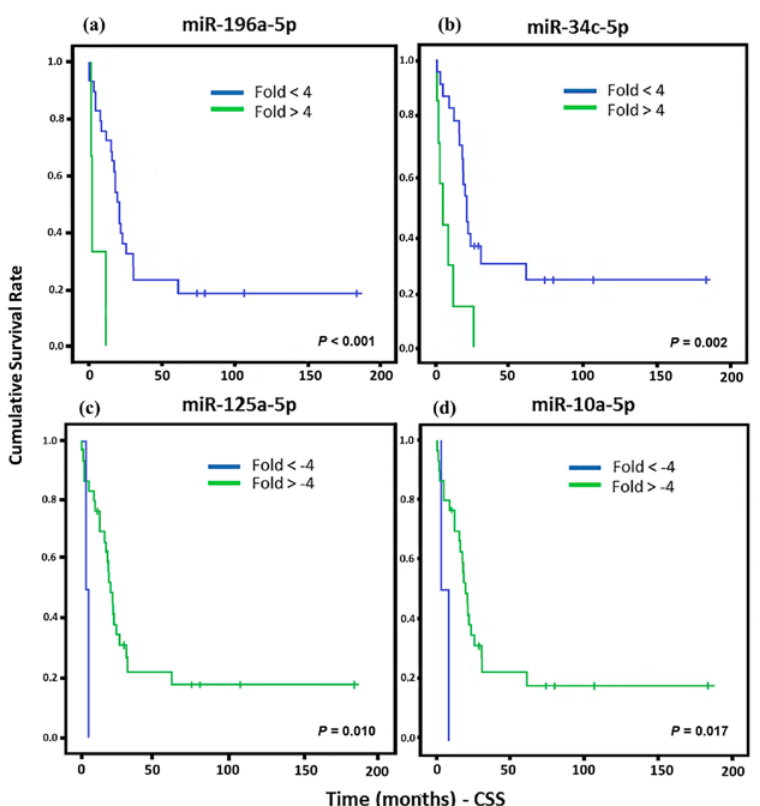
Figure 2. Kaplan Meier curves and estimates of cancer-specific survival (CSS) associated with miRNA expression in LMS patients. ( a ) miR-196a-5p showed a strong association with CSS ( n = 32) ( p < 0.001). ( b ) Association of miR-34c-5p expression with CSS ( n = 31) ( p = 0.002). ( c ) miR-125a-5p expression associated with CSS ( n = 32) ( p = 0.010). ( d ) miR-10a-5p expression was associated with CSS ( n = 32) ( p = 0.017).